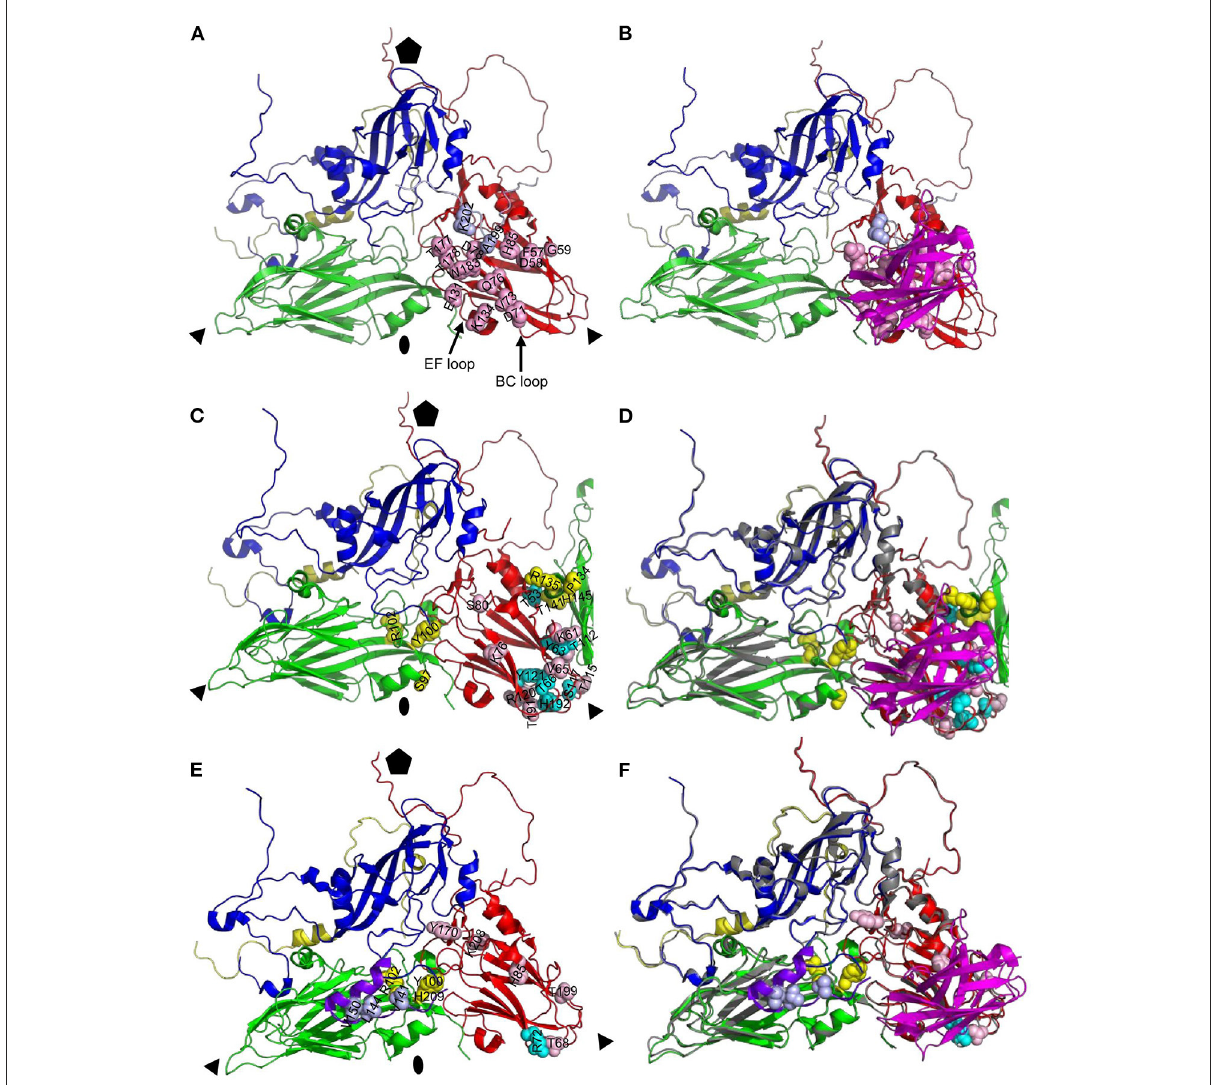
FIGURE6 Comparison of antigenic site of VHH M170 determined by cryo-EM and M702F and M691F determined by XL-MS. Protomers of O/BY/CHA/2010 [PDB: 7DST; (A, B) ] or A22IRQ [PDB: 4GH4; (C–F) ] are shown as cartoon with footprints of M170 (A, B) , M702F (C, D) or M691F (E, F) shown by indicating the side chains of residues within 4 Å of the VHH (A, B) or cross-linked to the VHH (C–F) as light blue (VP1), yellow (VP2), or cyan/pink (VP3) spheres. VPs and VHHs are shown as cartoon: VP1, blue; VP1 of O1K GH-loop (E, F) , purple; VP2, green; VP3, red; VP4, yellow; M170, magenta. The C-terminal 20 amino acids of VP1 from an adjacent protomer are shown as light blue cartoon to visualize the M170 footprint (A, B) . Part of VP2 from an adjacent protomer is shown to visualize the M702F cross-linked residues (C, D) . An alignment of the structures of A22IRQ (VP coloring as done throughout this paper) with M702F or M691F cross-linked residues and O/BY/CHA/2010 (gray) complexed to M170 is shown (D, F) . Fivefold symmetry axis, pentagon; 3-fold symmetry axis, triangle; 2-fold symmetry axis,